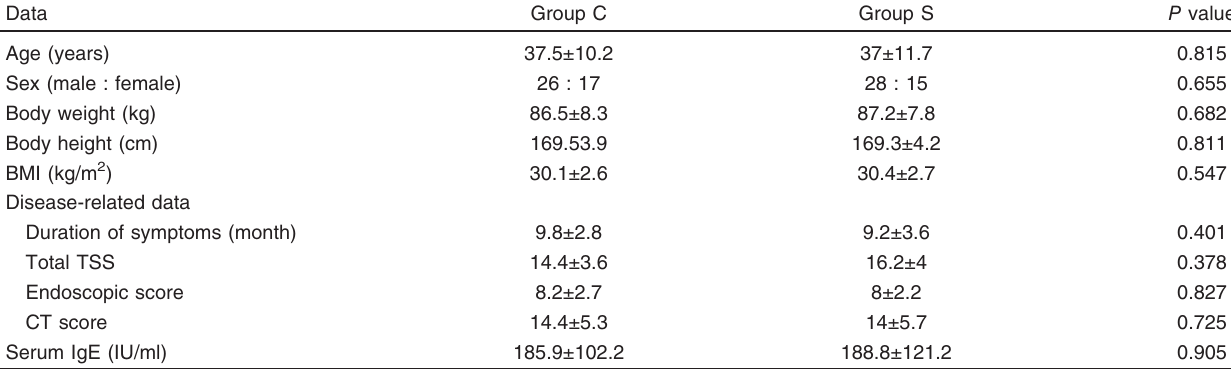
Table 2 Pretreatment data of the studied